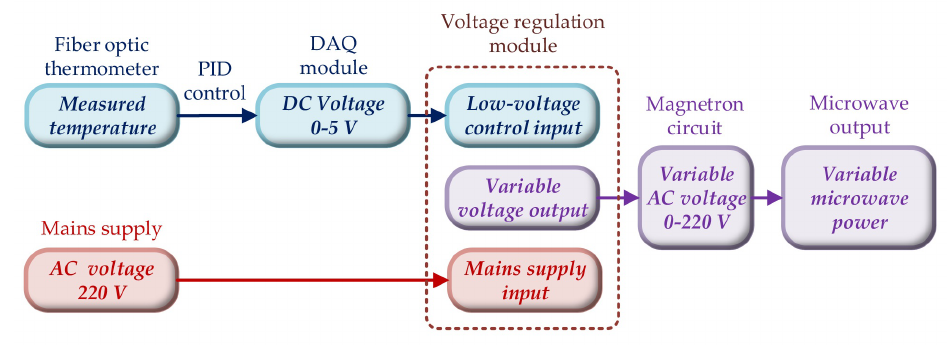
Figure 2. The implementation process of microwave power